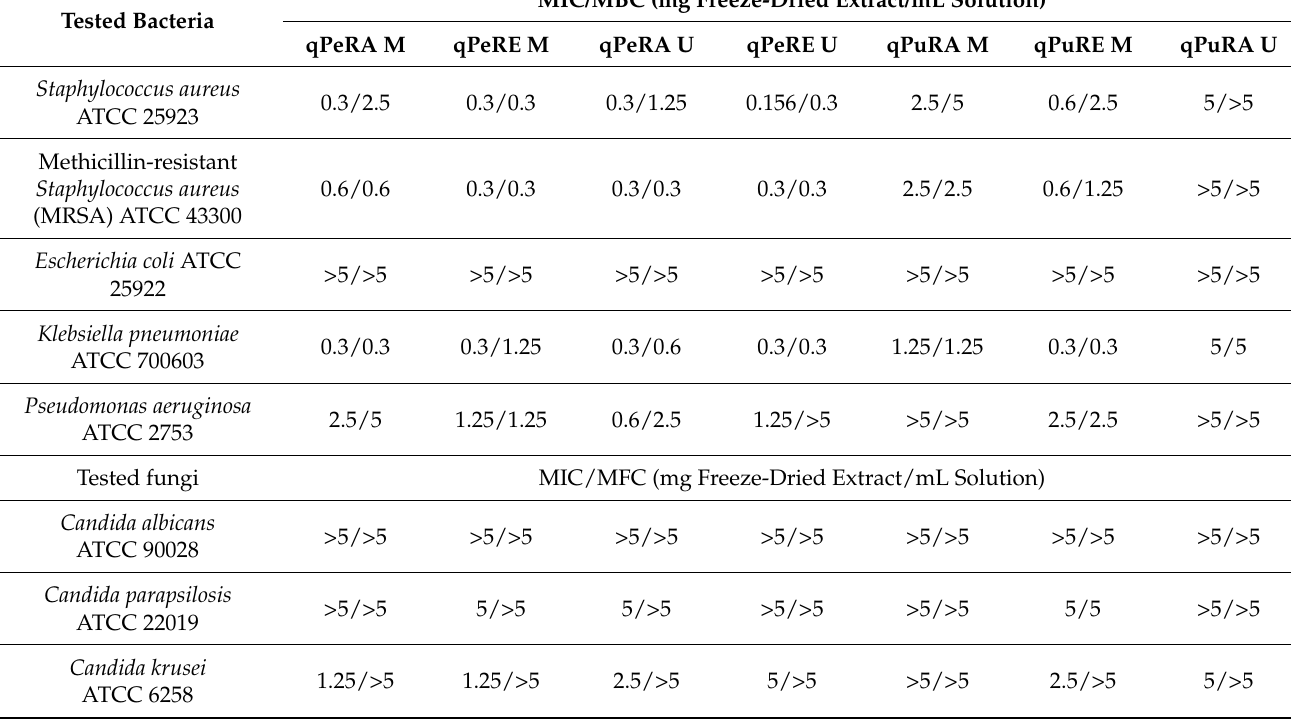
Table 1. MIC and MBC values of the tested extracts against the bacterial and fungal strain results expressed as mg freeze-dried extract/mL solution (concentration in the microtiter plate